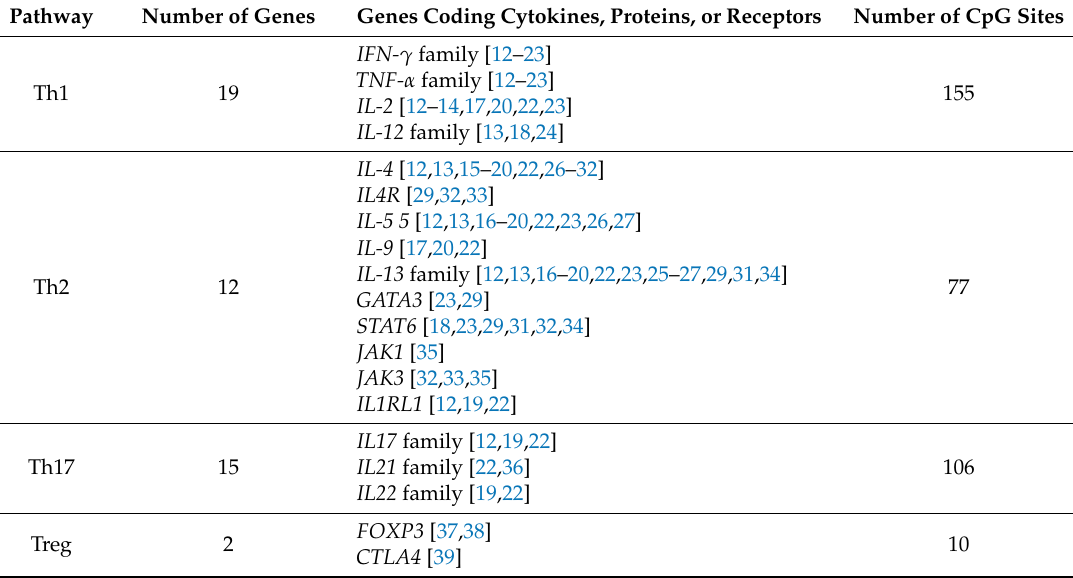
Table 1. Genes considered for T cell pathways in the study and their numbers of cytosine–phosphate– guanine (CpG) sites. Pathway Number of Genes Genes Coding Cytokines, Proteins, or